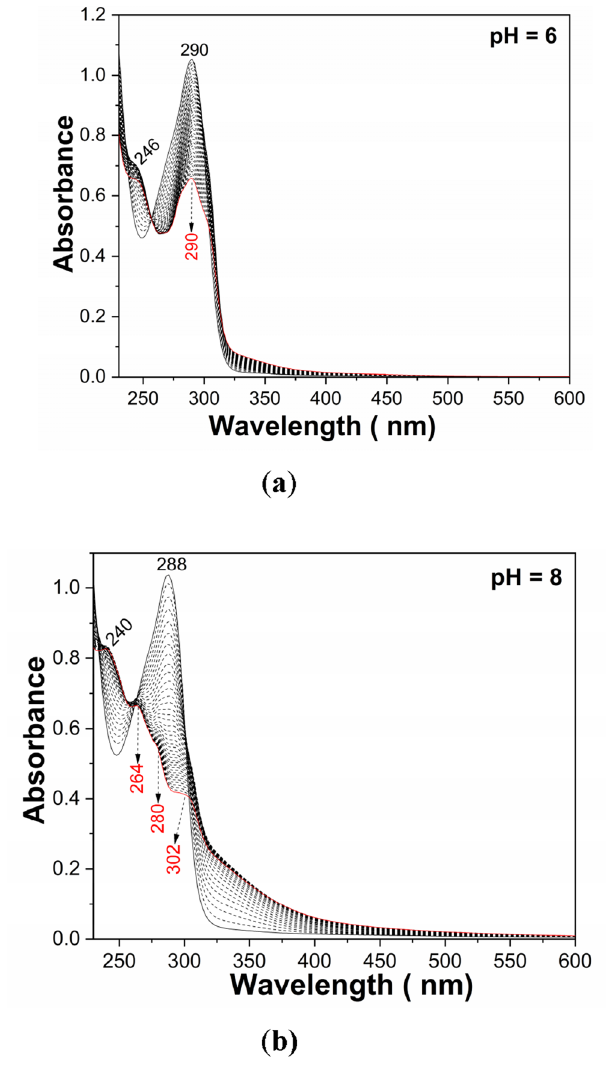
Figure 7. The UV–VIS spectra of the solution of PS ( 1 ; 2 mg/ml) in BP with the pH = 6 ( a ) and 8 ( b ) and their evolution during the 80 min. exposure to UV light. Black and red solid lines correspond to the UV–VIS spectra of the PS ( 1 ) solutions prior and after exposure to UV light, respectively, time of 80 min. Black dash lines correspond to the UV–VIS spectra of the PS ( 1 ) solution subsequently exposed for 2 min. to UV